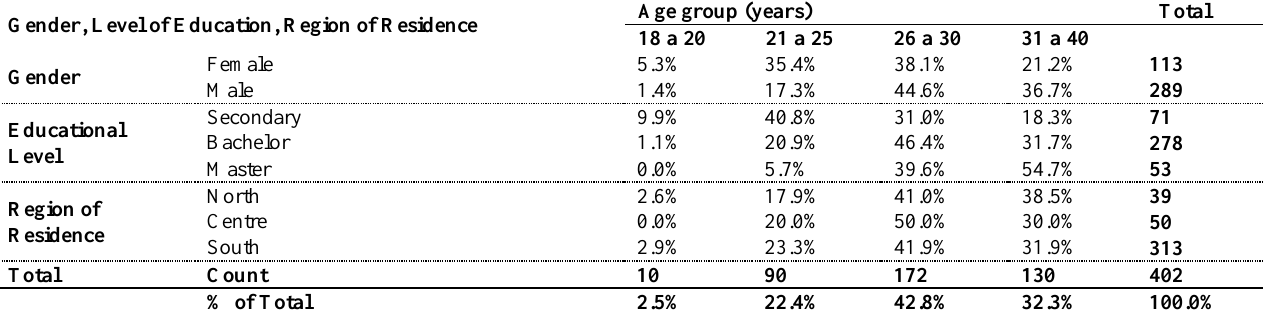
Table 1: Sample distribution by gender, age, educational level and region of residence Gender, Level of Education, Region of Residence